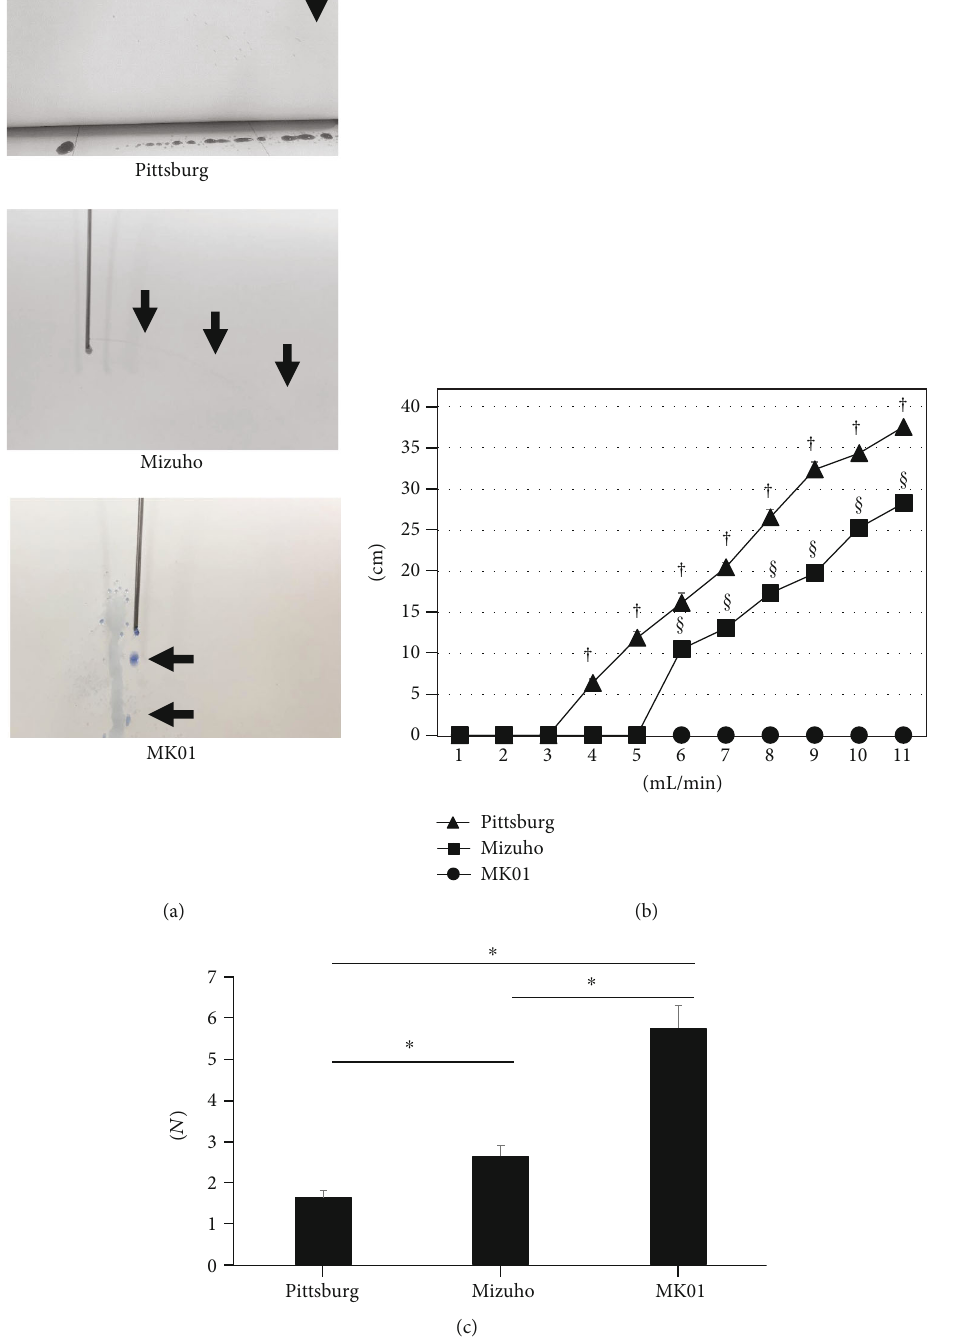
Figure 4: Representative fi gures of the jet fl ow with each cannula (a, arrow) and the distance reached by saline (b) ( † ,§ p < 0 : 05 vs. MK01). The force (N) needed to cause vertical jet fl ow (fountain) (c) ( ∗ p < 0 : 05